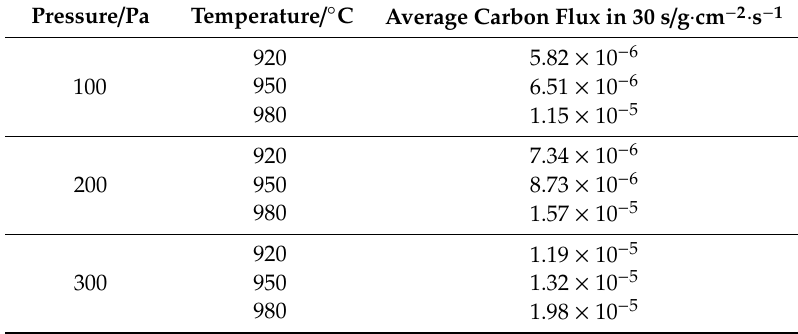
Table 4. E ff ect of carburizing temperature and pressure on average carbon flux of 18Cr2Ni4WA